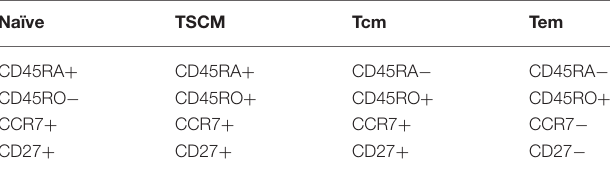
TABLE 4 | Expression of markers that differentiate each subset of memory cells. Naïve